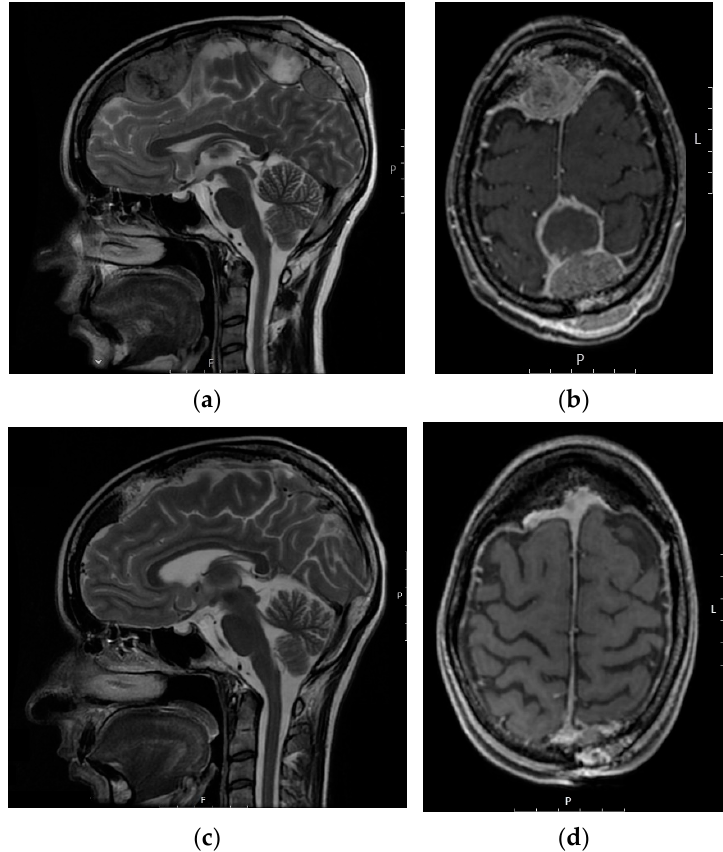
Figure 1. Axial T1-post IV contrast ( a ) and sagittal T2-weighted ( b ) MRI images of a 21-year old female with alveolar soft part sarcoma at the diagnosis of two large brain metastases with meningeal involvement and known skull bone metastases. The patient was treated with whole-brain radiotherapy (WBRT) and several different systemic therapies. Axial T1 ( c ) and sagittal T2-weighted ( d ) MRI images performed 2 years after WBRT, showing a very good response to treatments.